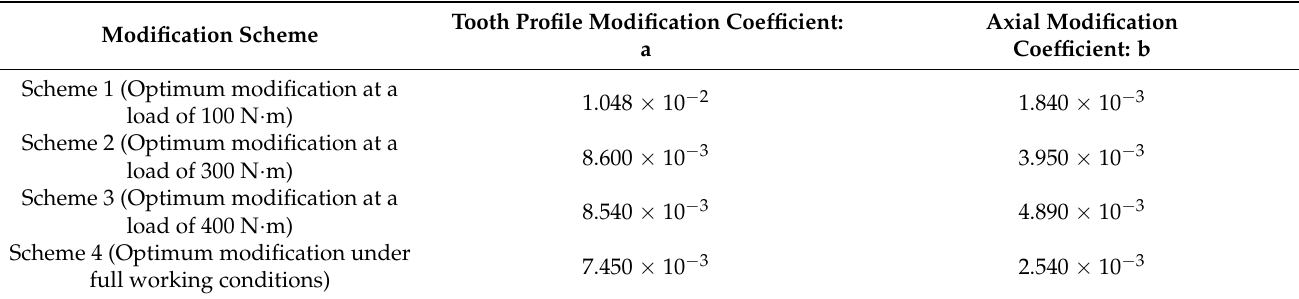
Table 3. Genetic algorithm optimization results.